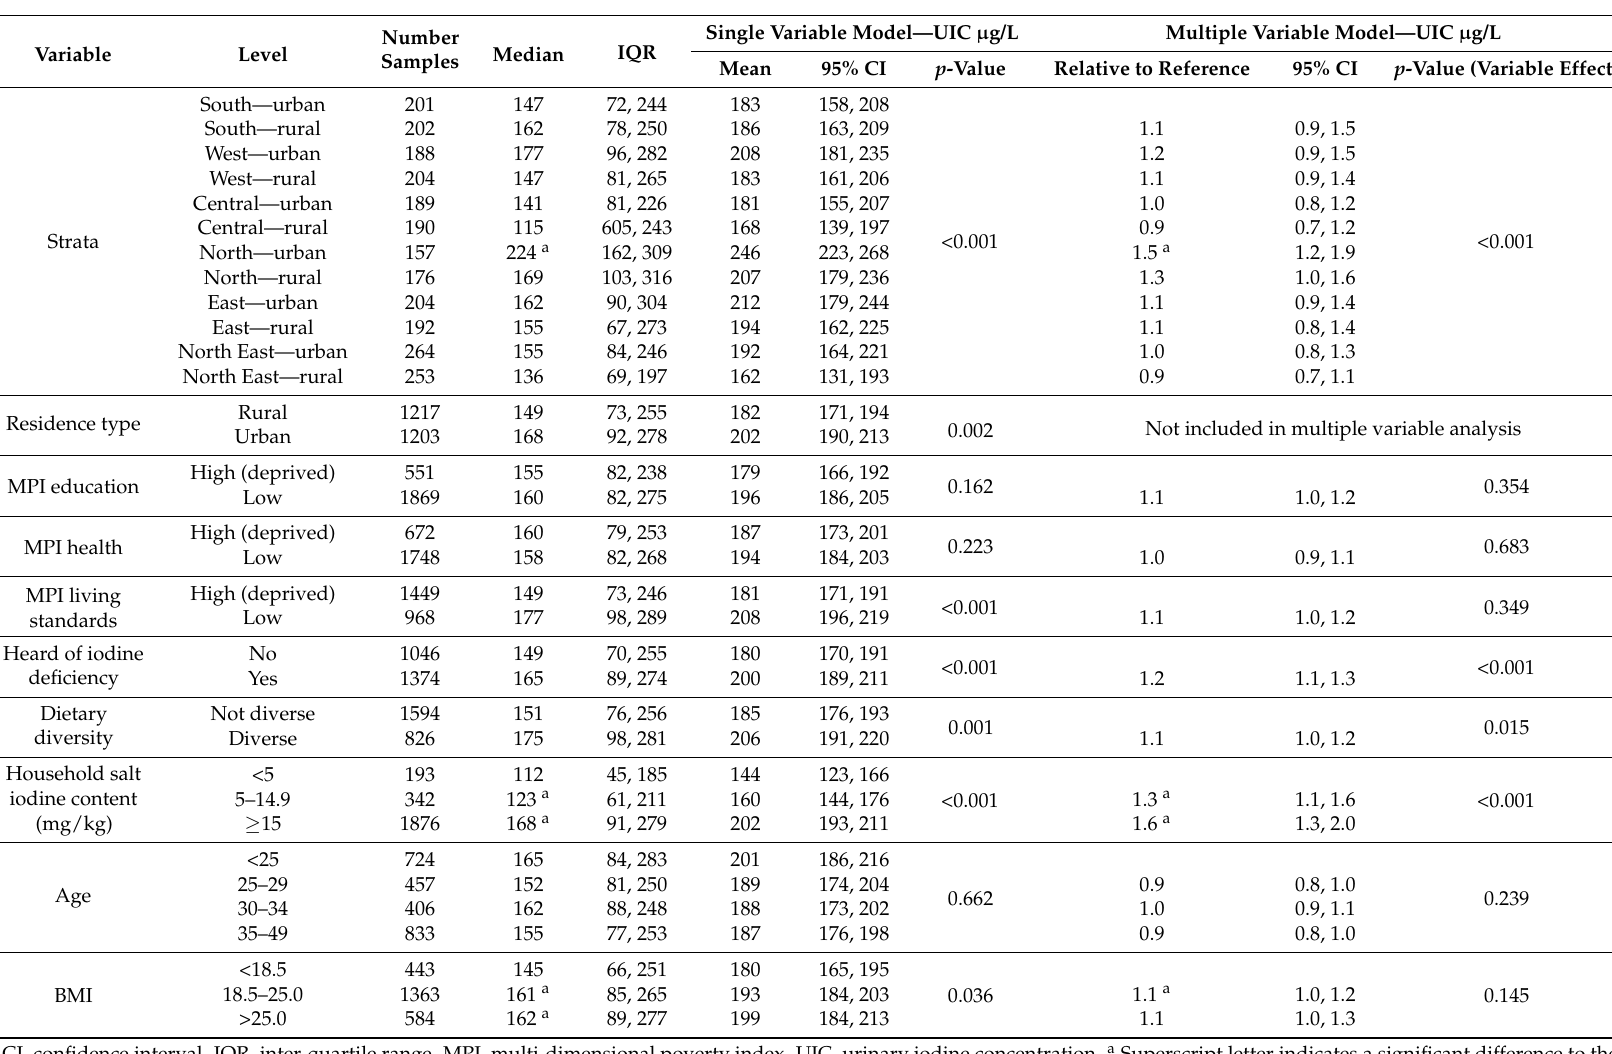
Table 2. Regression analyses of factors associated with urinary iodine concentration (UIC) µ